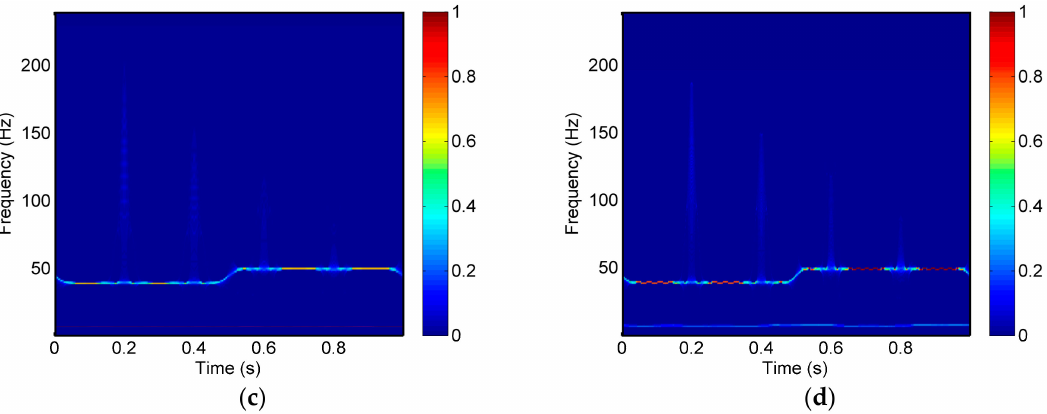
Figure 6. Time-frequency spectra of the synthesized signal based on ( a ) CWT; ( b ) GST; ( c ) SSCWT; ( d ) SSGST.